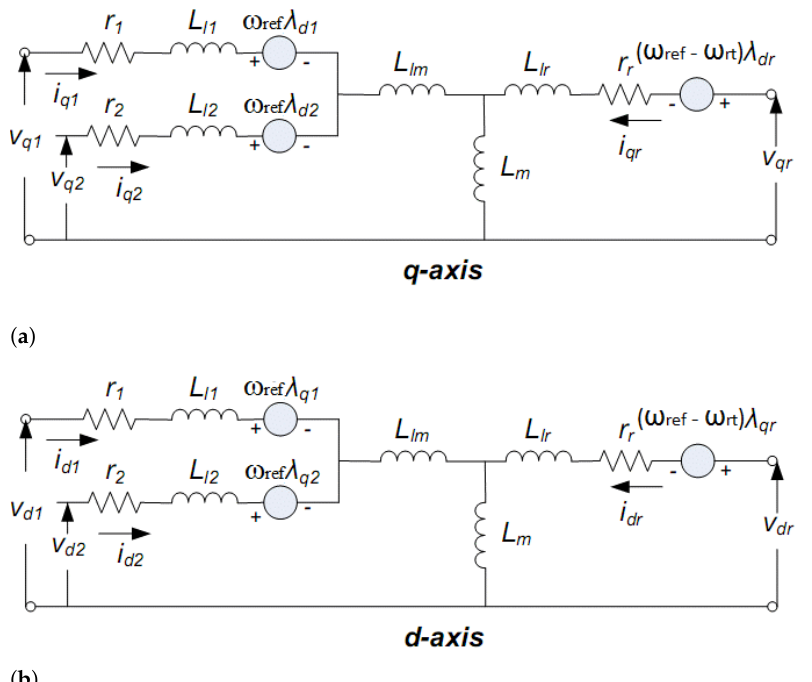
Figure 1. Dynamic equivalent circuit of the six-phase induction motor in an arbitrary reference frame [19]. ( a ) q-axis equivalent circuit of the six-phase induction motor. ( b ) d-axis equivalent circuit of the six-phase induction